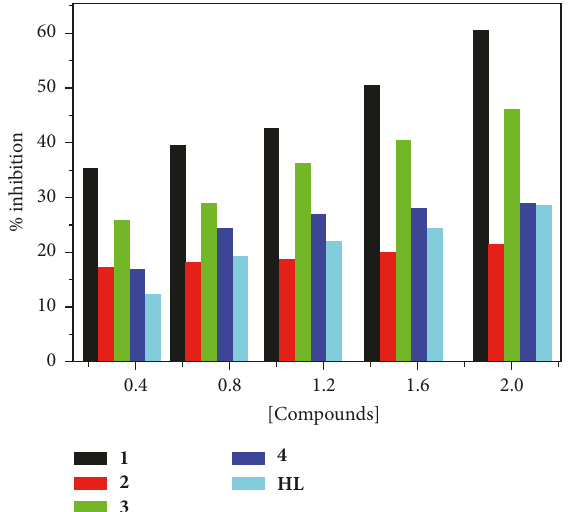
Figure 5: % inhibition of HL and complexes 1 – 4 with DPPPH free radical.